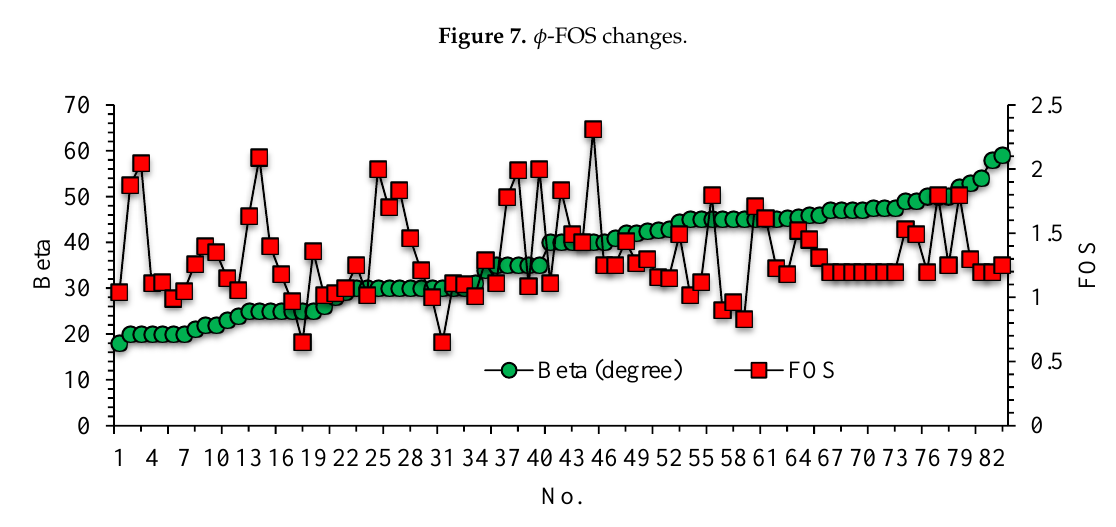
Figure 8. β -FOS changes. Figure 8. β -FOS